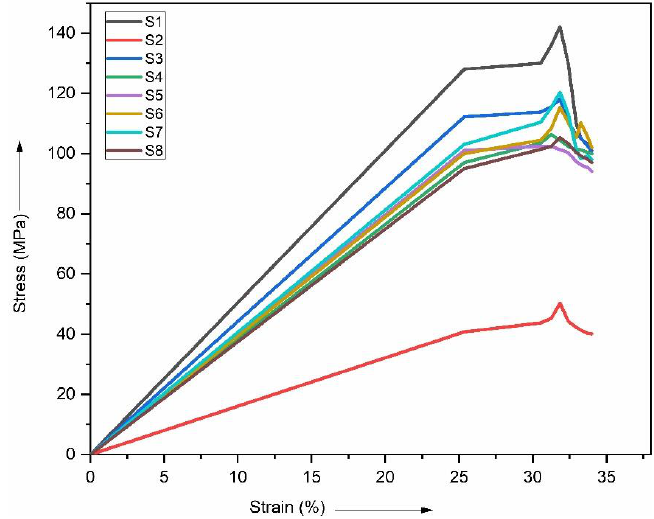
Figure 9. Stress vs. strain of tensile